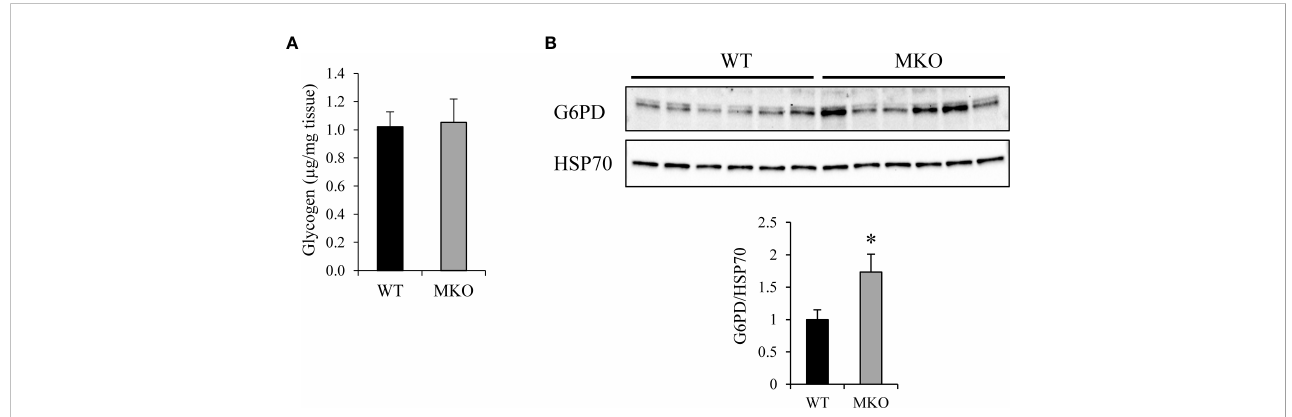
FIGURE 9 Glucose 6-phosphate dehydrogenase (G6PD) expression was upregulated in Arid5b MKO GC. (A) Glycogen content was measured in Arid5b WT and MKO GC. (n=5). Data are presented as the means ± SE. (B) G6PD expression was analyzed by Western blot in Arid5b WT and MKO GC and normalized to HSP70 expression. Quantitation was performed, and results are expressed as the means ± SE. *, p <